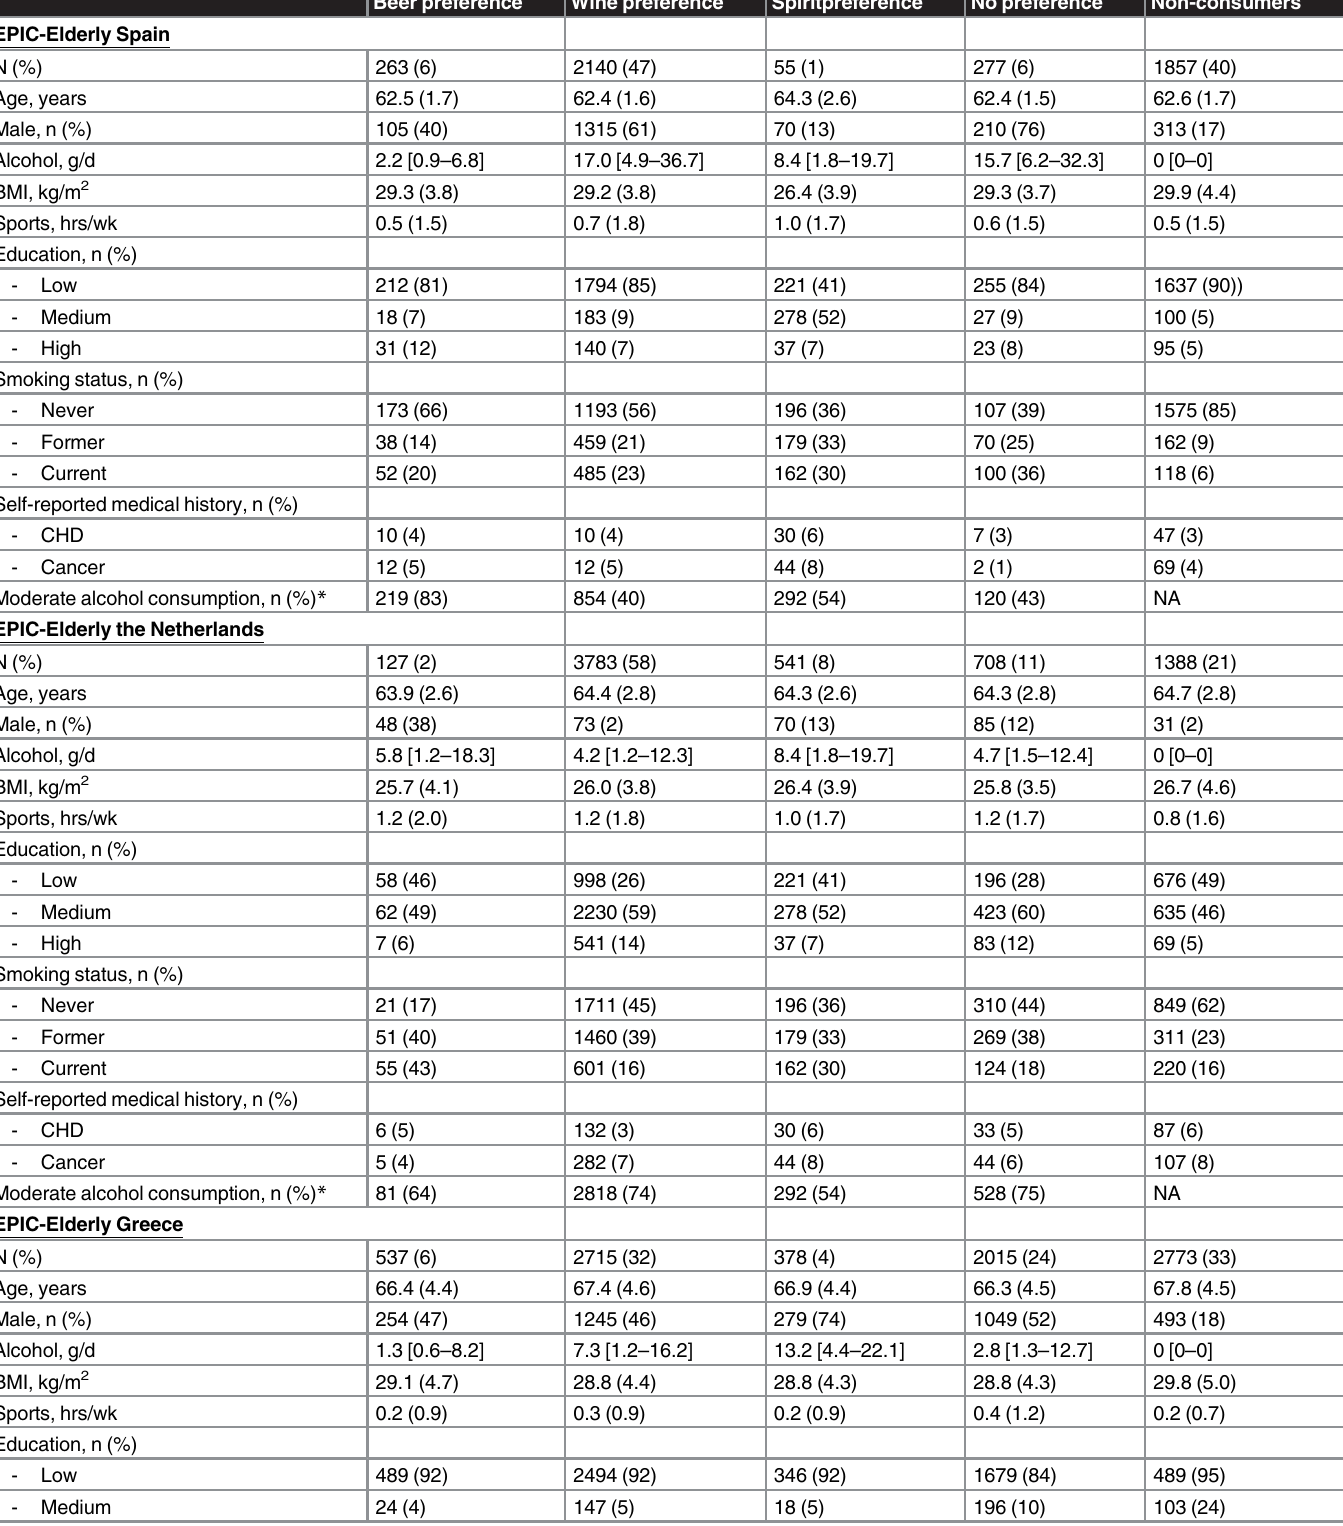
Table 1. General characteristics of elderly included in the EPIC-Elderly (Spain, the Netherlands, Greece, and Sweden), Rotterdam Study, SENECA (Northern Europe and Southern Europe), and the Zutphen Elderly Study across categories of alcoholic beverage